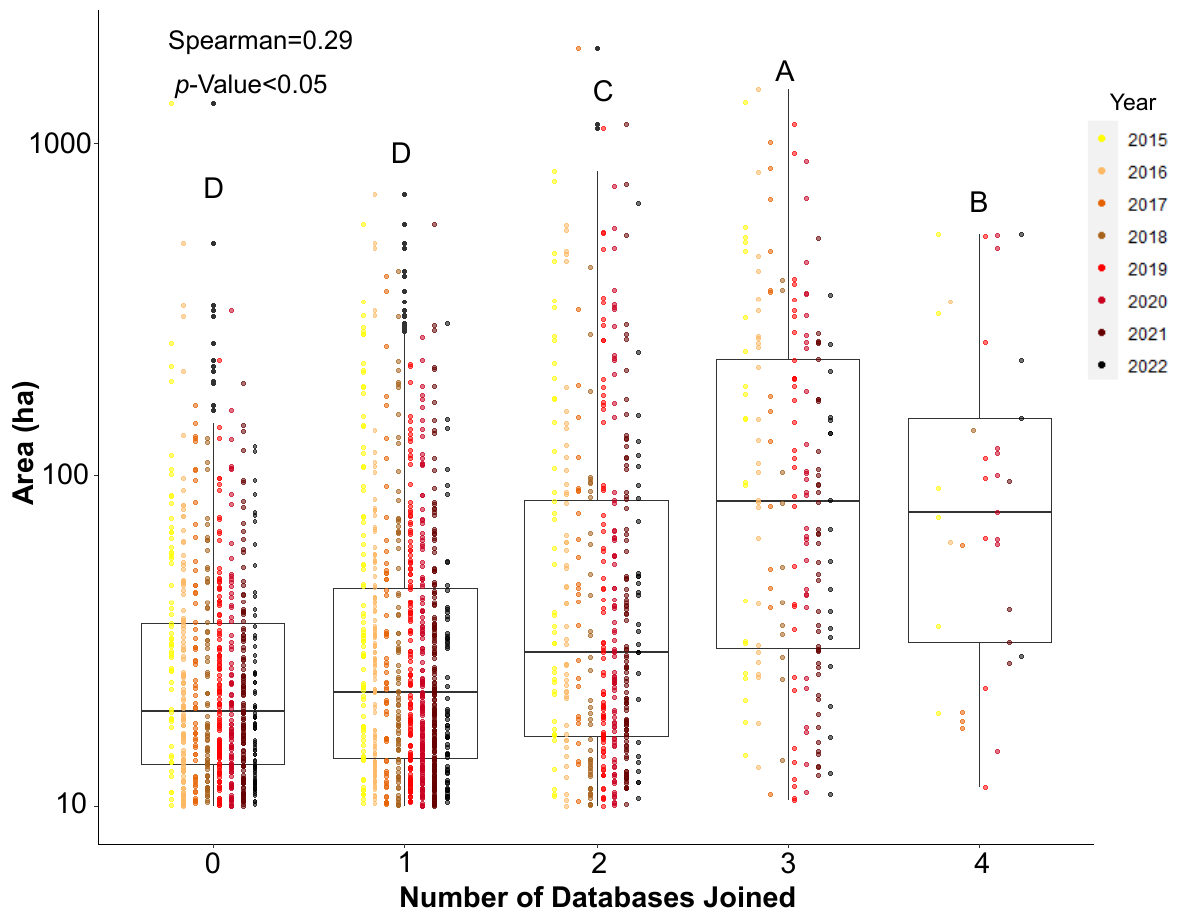
Figure 7. The number of databases joined to each wildfire event (2015–2022) and the area burned.